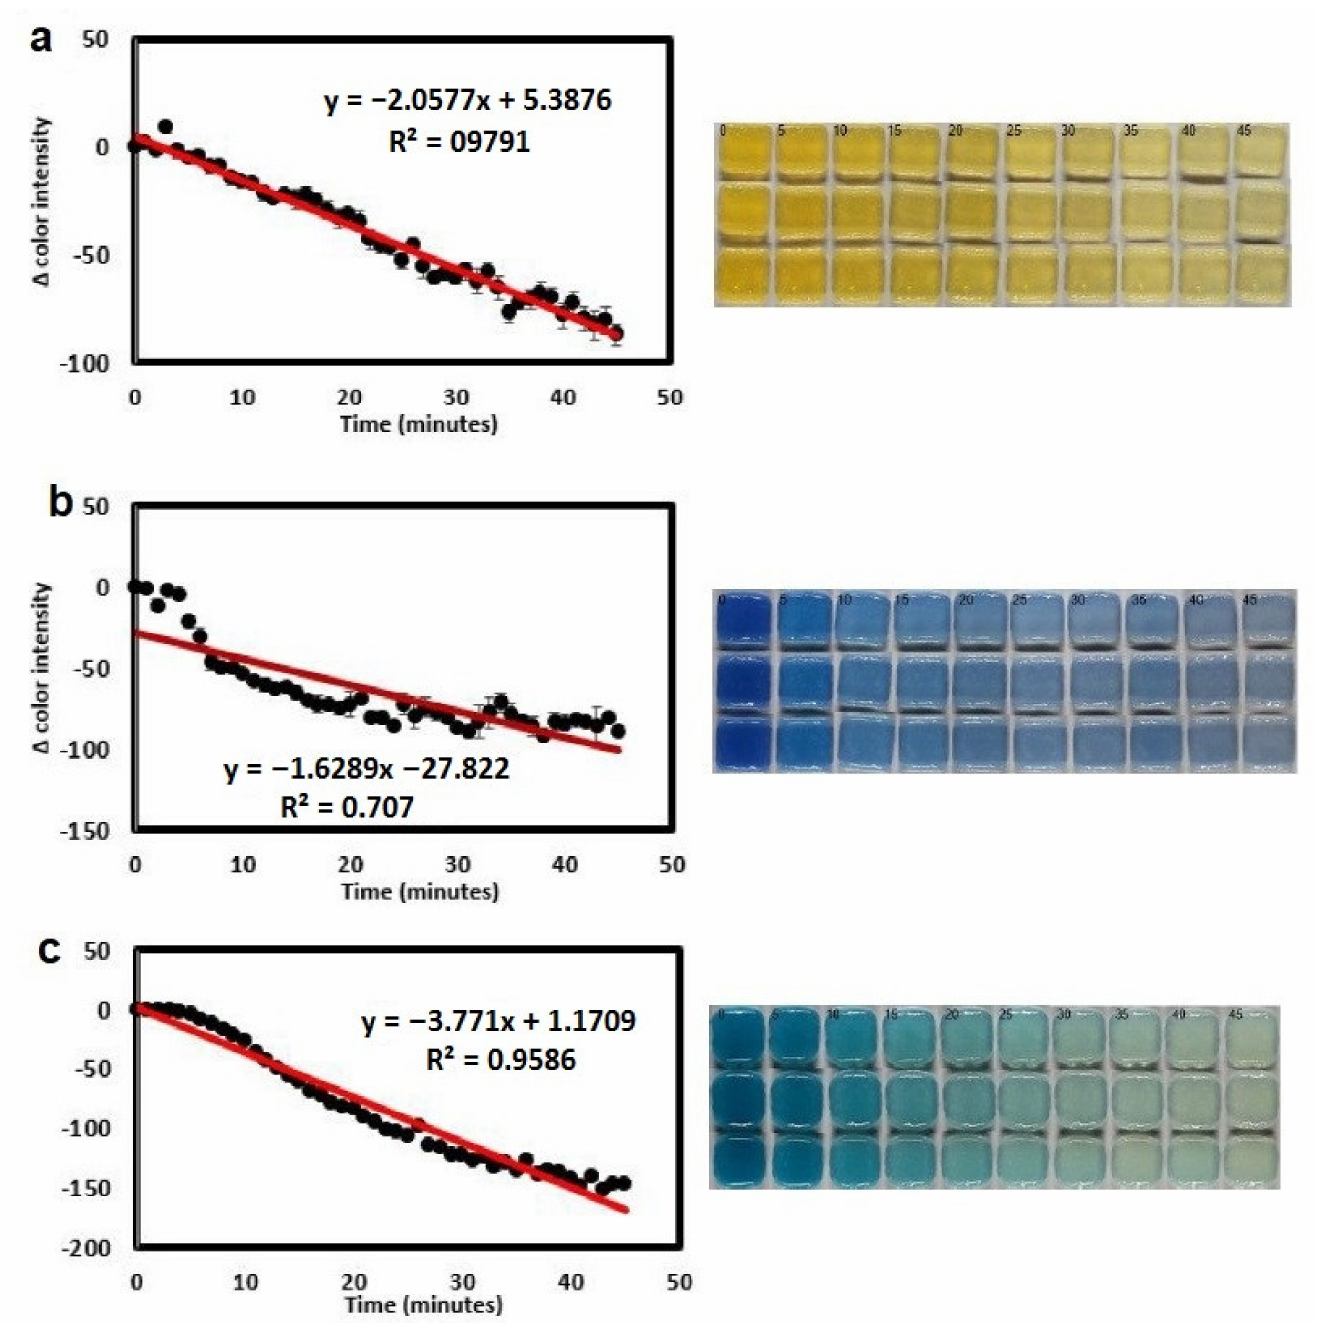
Figure 14. Colorimetric response showing discoloration resulting from the photocatalytic degradation of the three dyes following 45 min exposure for sensors for methyl orange ( a ); %RSD Minimum = 2.80, Maximum = 12.54, Mean = 6.15, methylene blue ( b ); %RSD Min = 3.18, Max = 14.21, Mean = 6.83, and malachite green ( c ) sensors; %RSD Min = 0.26, Max = 17.60, Mean = 3.14. Copyright 2020 ACS. Reprinted with permission from ref.